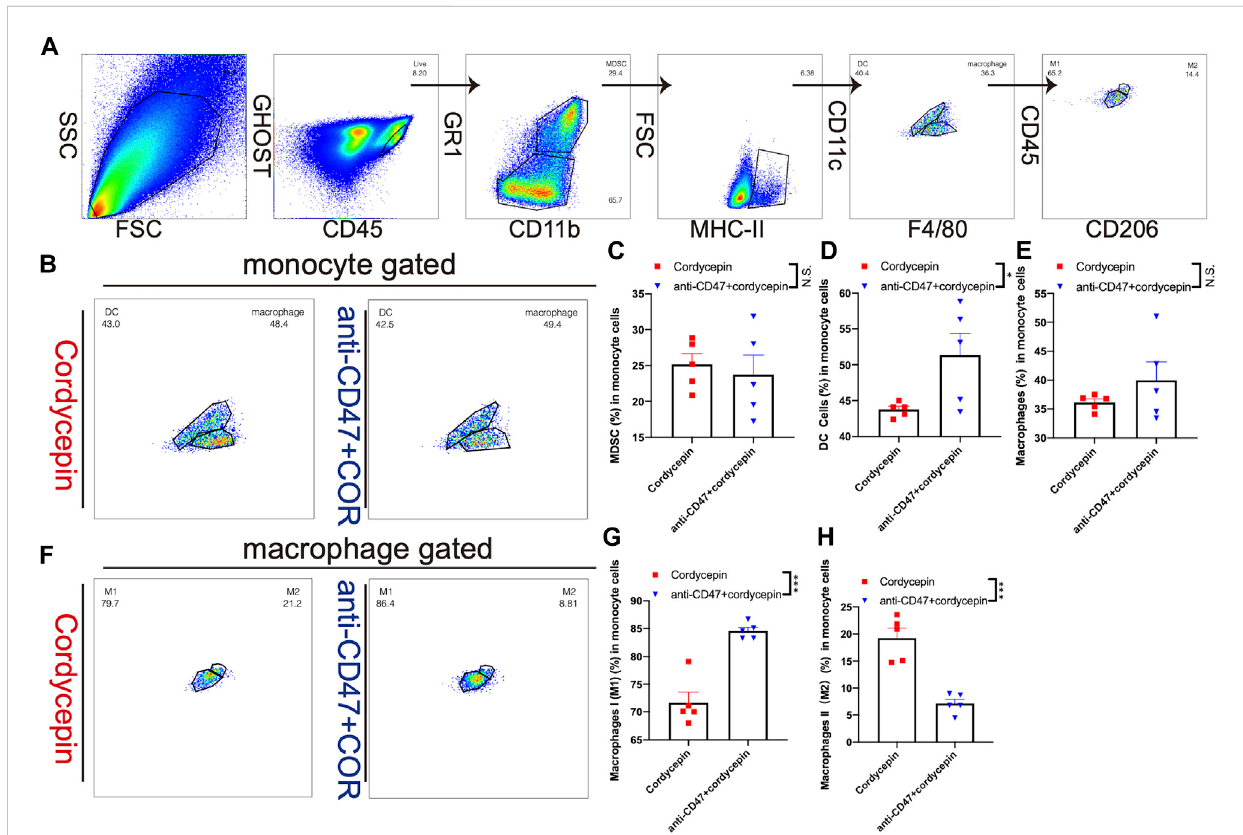
FIGURE 7 Change level of TAMs is shown by fl ow cytometry (A) . Gating strategy for fl ow cytometric phenotyping was used to identify the proportions of macrophagesand DCs (B) . Different proportions of macrophagesand DCs are shown by adot plot. ( n = 5, representativeresults from three